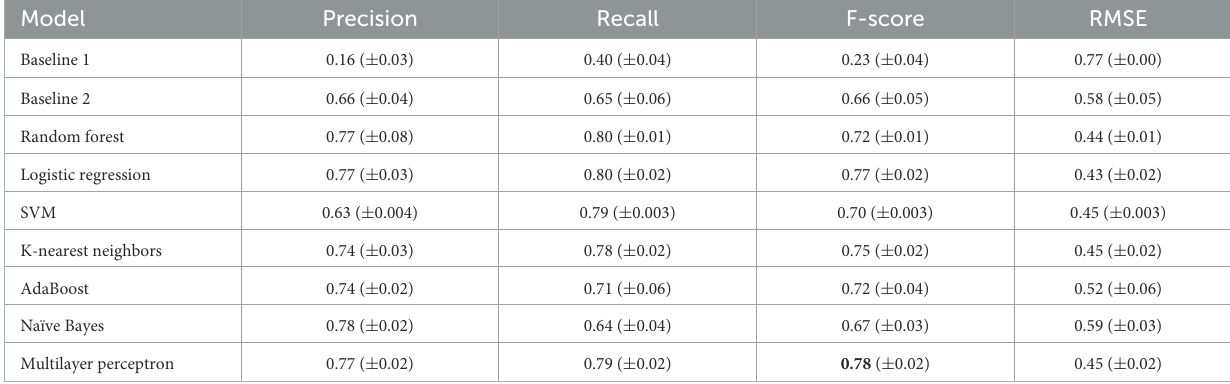
TABLE 3 Results of 2-class engagement level classification (standard deviation in parentheses).